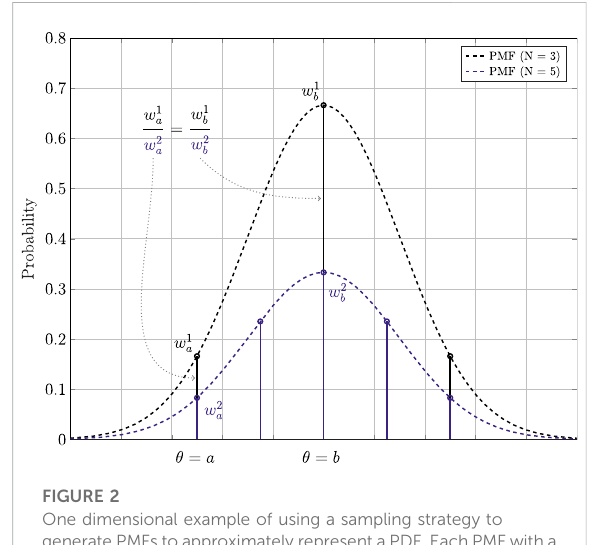
FIGURE 2 One dimensional example of using a sampling strategy to generate PMFs to approximately represent a PDF. Each PMF with a different number of particles N is shown with a different color.